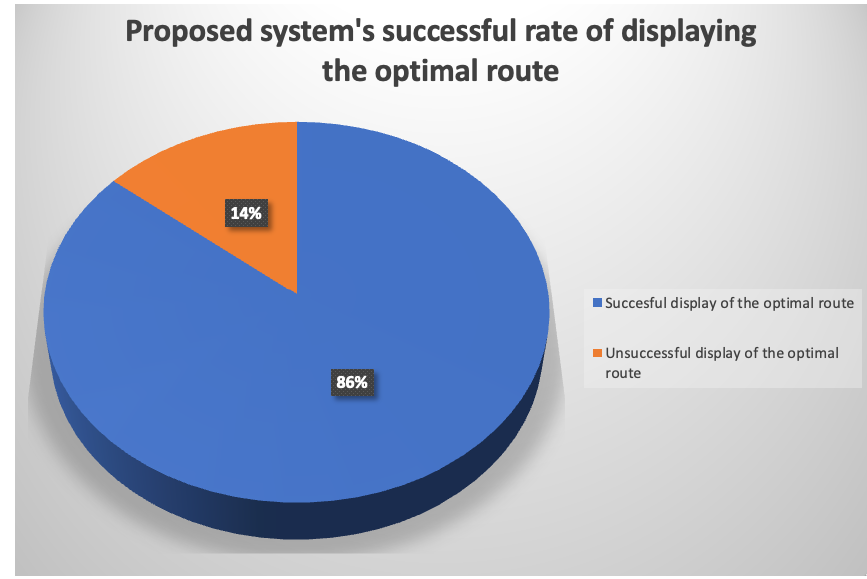
Figure 3. Successful rate in regard to the display of the optimal route from the proposed system.